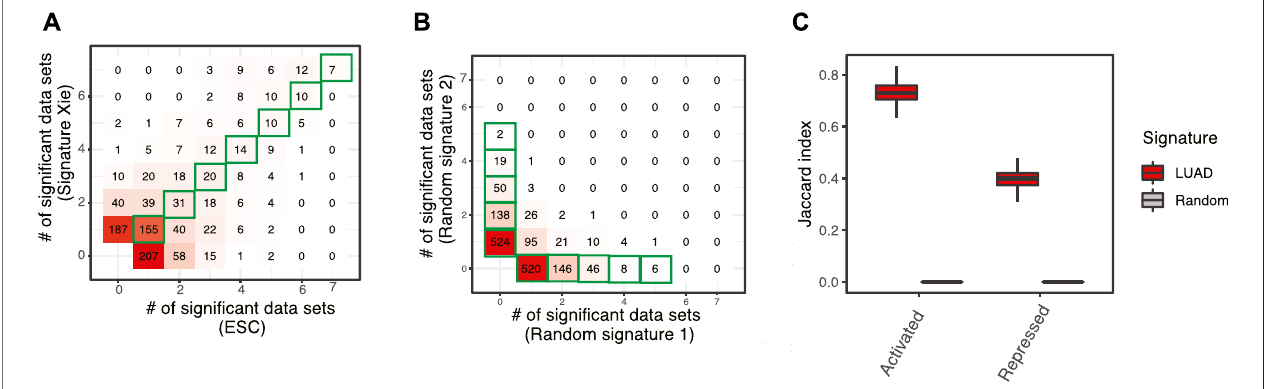
FIGURE 2 | A work fl ow to identify master regulators driving prognosis in patients with LUAD. (A) Comparison of master regulators predicted with two well- established LUAD signatures, one was the best-scoring signature benchmarked in a previous review study (Xie signature) (Xie et al., 2011), the other is embryonic stem cells signature (ESC) (Ben-Porath et al., 2008). Both signatures were tested across seven LUAD gene expression datasets and master regulators were identi fi ed with a p -valuecutoffof0.01( Section2 ).Theresultsweresummarizedtoshowhowmanytimesamasterregulatorwasidenti fi edandrepresentedasa2Dhistogram. (B) Comparison of master regulators predicted with random signatures. (C) Evaluation of robustness. The Jacard index shows the similarity of master regulators predicted from subsampling of LUAD signatures (100 times), as well as that from random background.